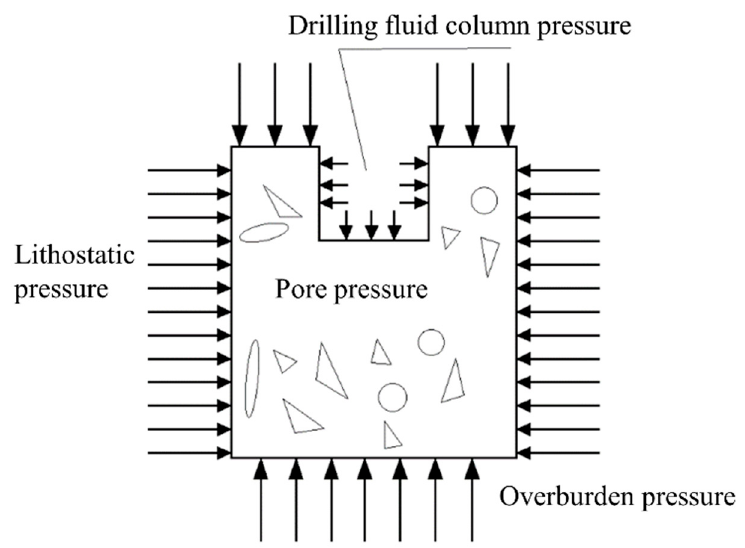
Figure 2. Stress state of rock at the bo tt om of the